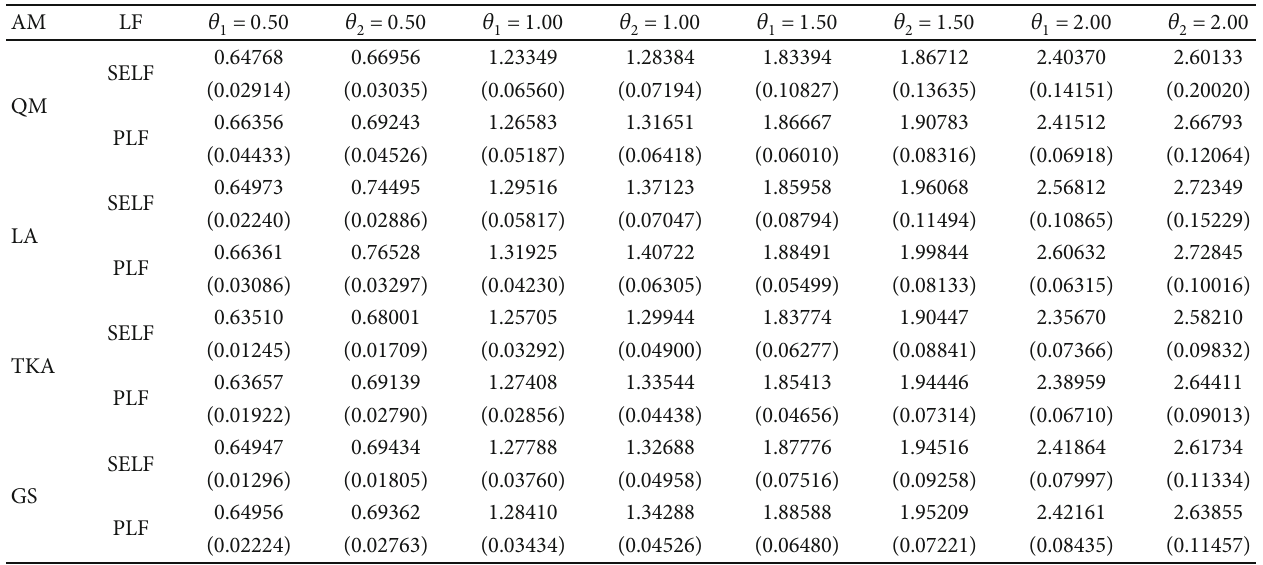
Table 1: BEs and PRs (in parenthesis) under IP for n = 15